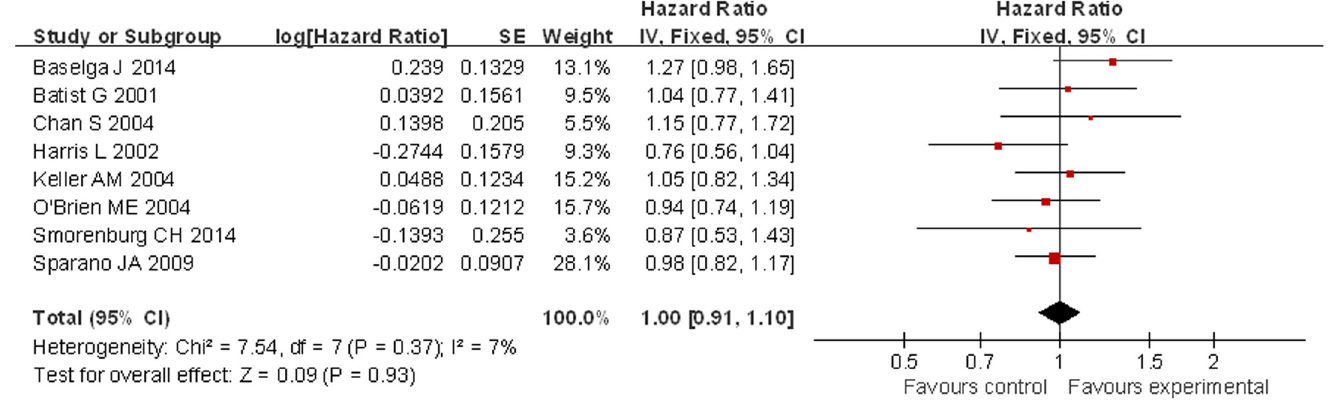
Fig 4. Forest plot of OS comparison between two groups.